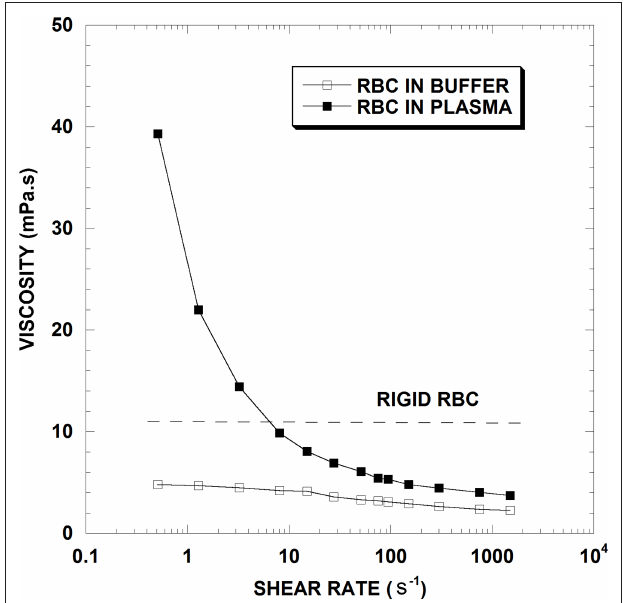
Figure 1 | Viscosity-shear rate results for 40% hematocrit suspensions of normal human rBC in plasma, in isotonic saline buffer and for chemically fixed rigid rBC in saline (From Cokelet and Meiselman,